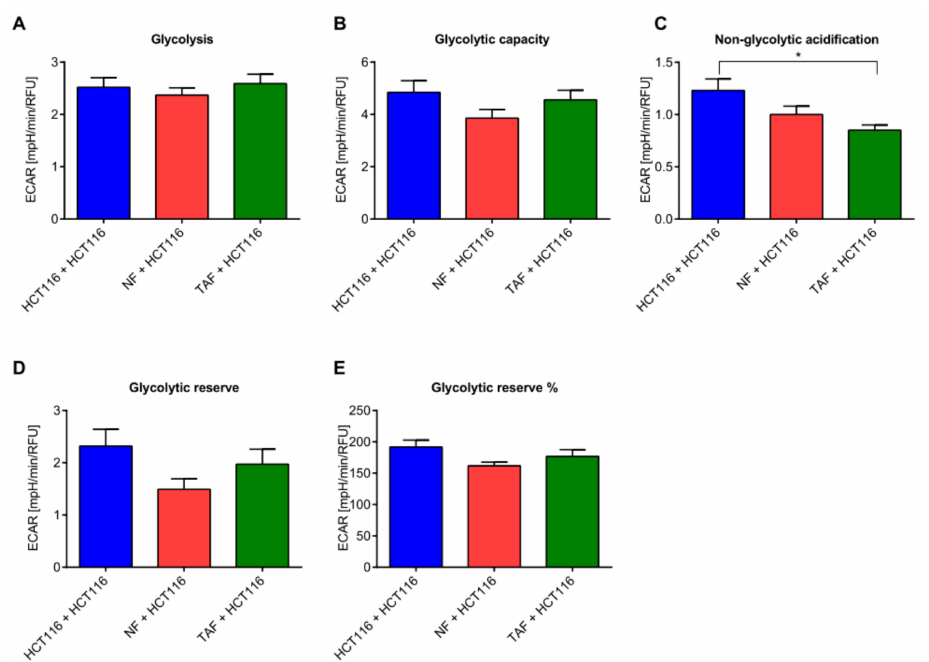
Figure 5. Cell-to-cell communication impacts cell metabolism: glycolysis. ( A ) Glycolysis, ( B ) glycolytic capacity, ( C ) nonglycolytic acidification, ( D ) glycolytic reserve, and ( E ) glycolytic reserve (%) in HCT116 cells cultivated alone or after co-culture with NFs or TAFs. Only HCT116 cells were measured. Data are represented as mean ± SEM ( n = 8). Significant changes ( p < 0.05) between di ff erent conditions are marked with